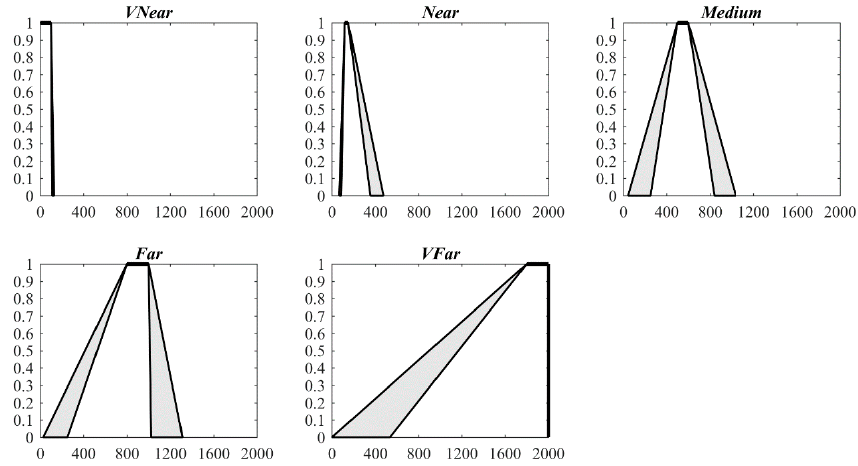
Figure 7. IT2 FSs of five qualitative distance words for train (unit: km).